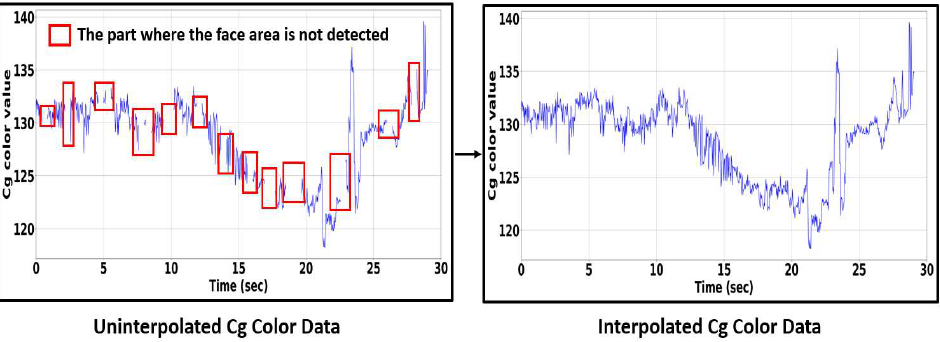
Figure 20. Process of interpolation for a Cg signal.